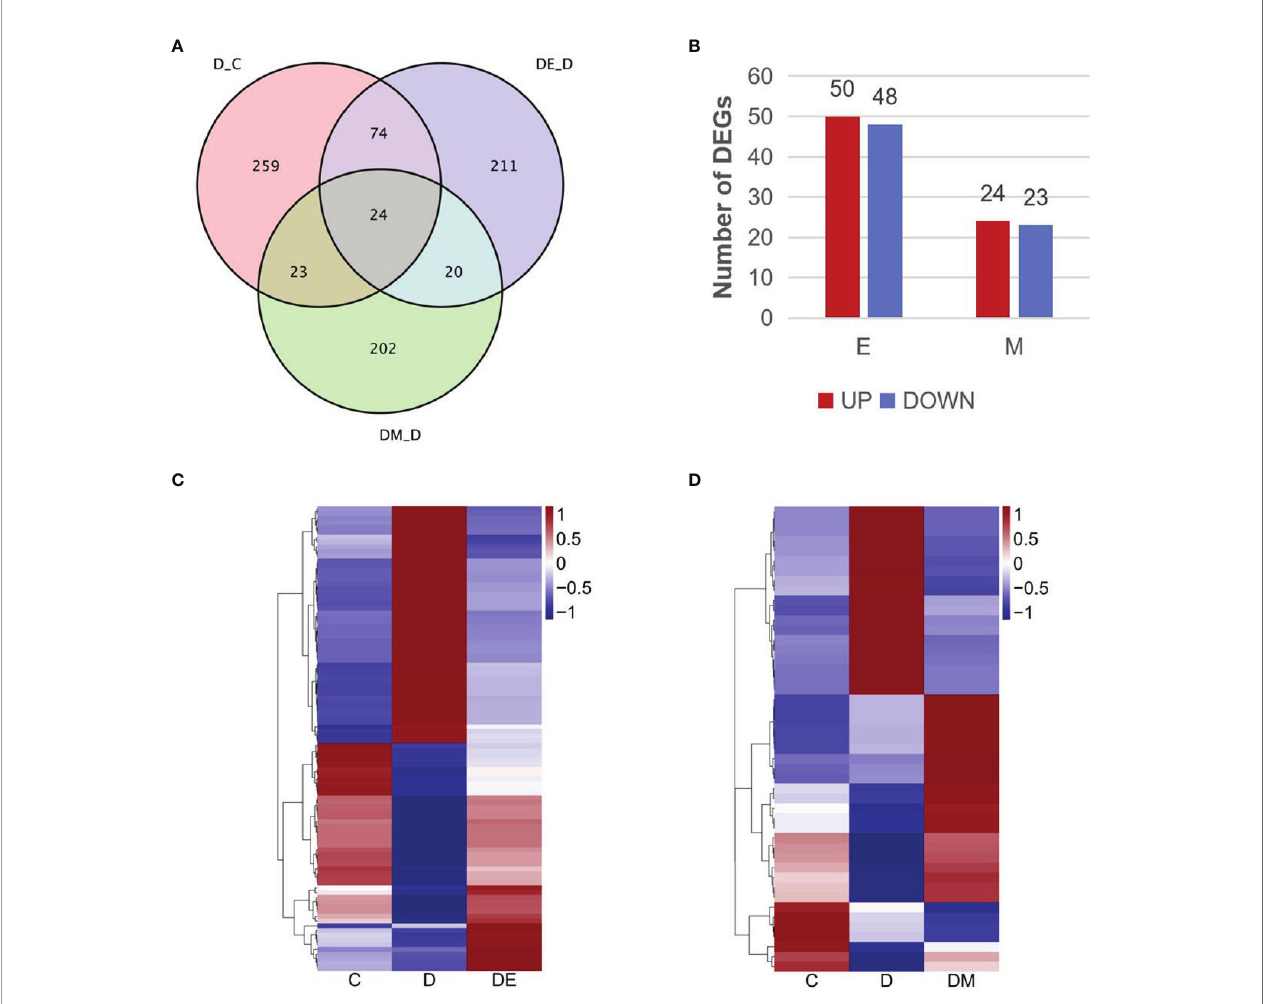
FIGURE 4 | Transcriptomic pro fi ling of differentially expressed genes. (A) Venn diagram describing the overlap of DEGs in the three comparisons (D vs. C, DE vs. D, DM vs. D). (B) Numbers of upregulated and downregulated DEGs in the three comparisons. (C, D) Heatmap representing the relative expression levels of DEGs in the three comparisons. Blue and red represent down and up regulation respectively, and white shows no signi fi cant change. C (control), D (diabetic), DE (diabetic+ exercise), DM (diabetic + MOTS-c), E (D-C vs. DE-D), M (D-C vs.